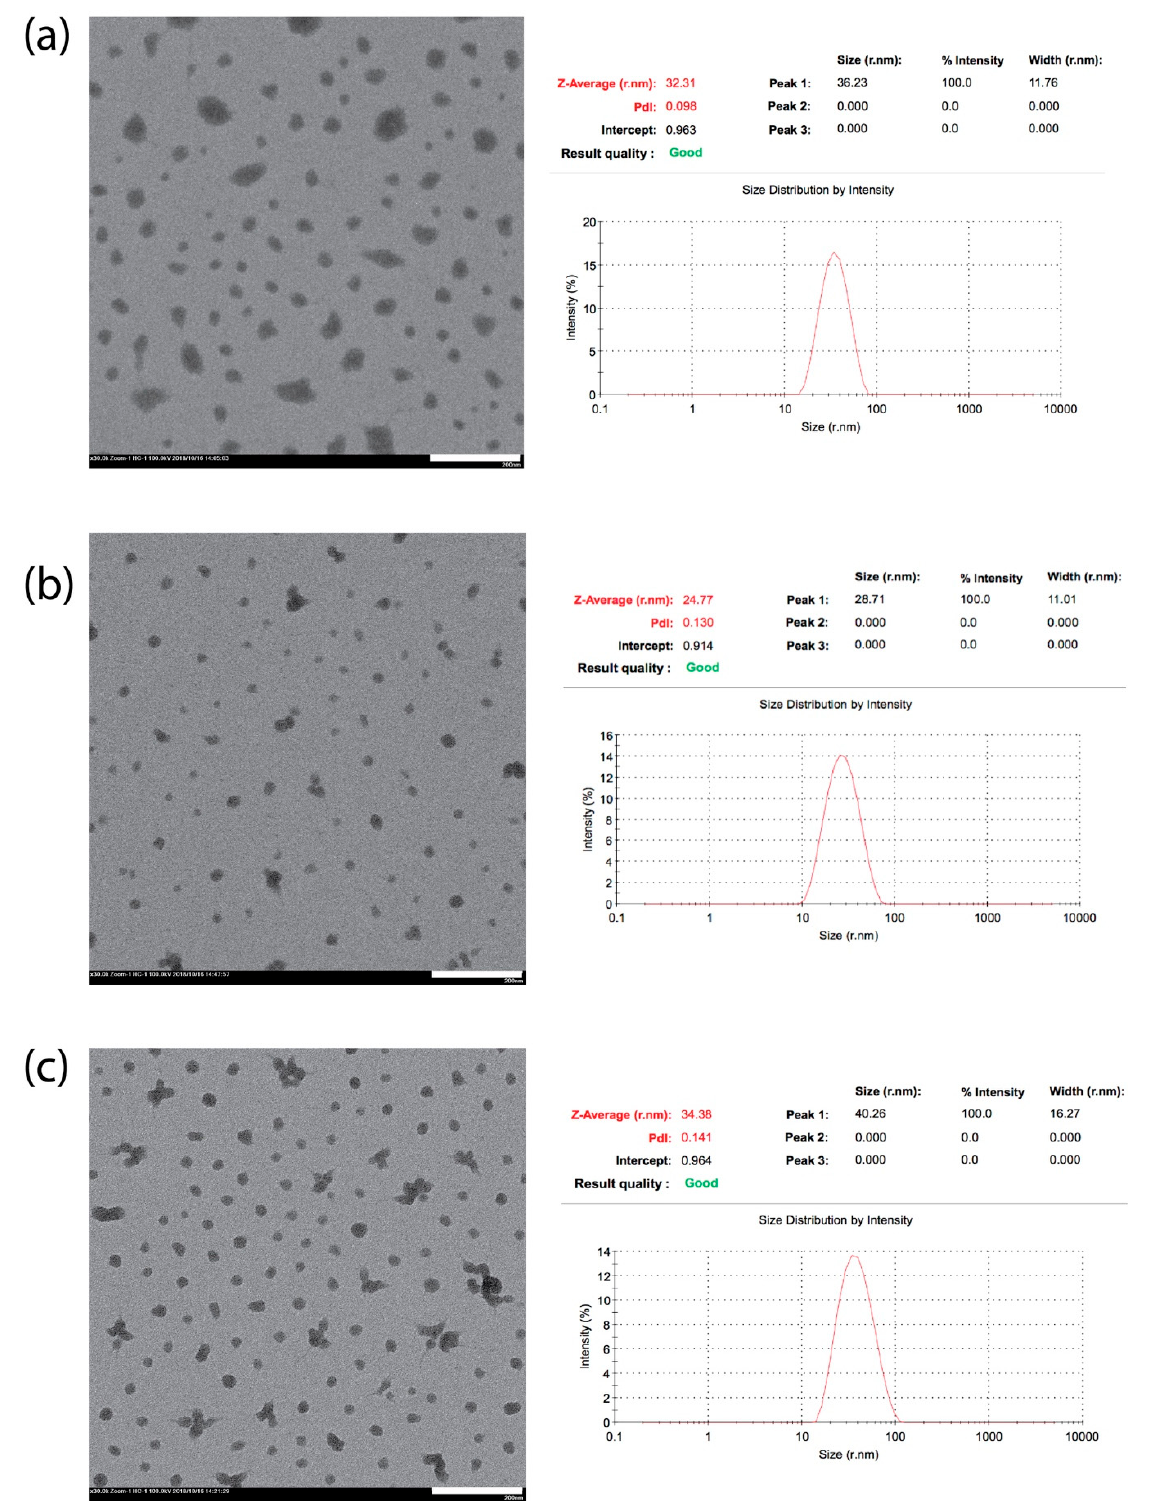
Figure 3. TEM and DLS analysis of Lux-2 mRNA condensed nanomicelle of ( a ) PEG-PAsp(DET), ( b ) PEG-PAsp(TET) and ( c ) PEG-PAsp(TEP) with the white bar representing 200 nm. Both DET and TEP were found to be marginally larger (31–35 nm) compared to TET (~24 nm), and this has been attributed to the uneven extension of chain arm upon aminolysis.